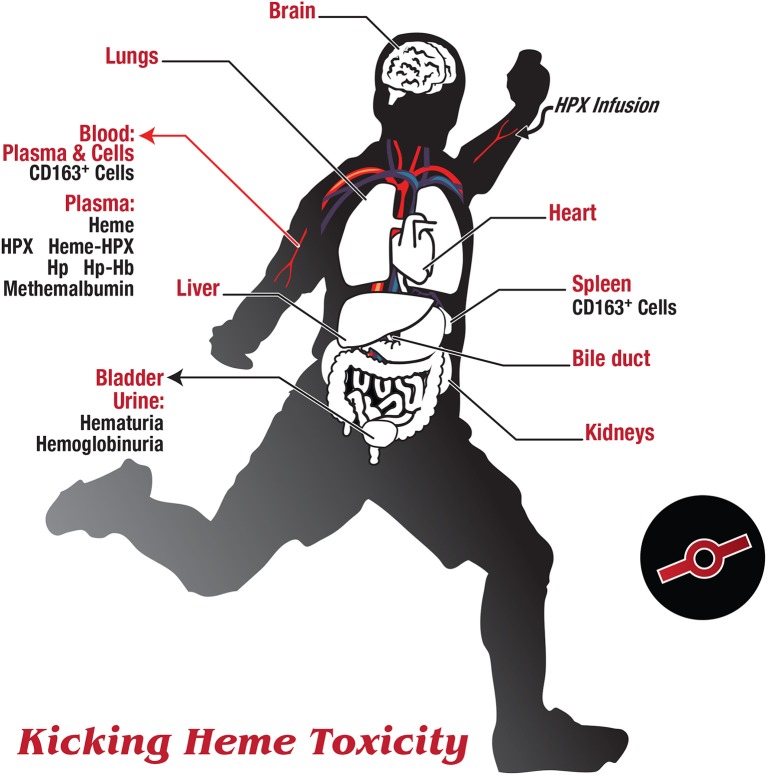
Kicking heme toxicity. As originally suggested by Delanghe et al. (2010) and Drieghe et al. (2013), there is at the bedside a currently unrecognized and potentially quite frequent need to distinguish impaired heme clearance from ongoing hemolysis. Several major organs may be involved in the pathology of heme toxicity, including the liver, lungs, heart, spleen, intestine, and kidney. Certain immune-privileged sites such as the brain and gonads are initially protected by strong endothelial barriers with tight junctions, and certain immune-privileged cells exist in an immunosuppressive environment. Thus, endothelial cells provide a physical barrier and epithelial cells provide a selective cell gate. Several markers in blood and urine samples are indicated here, in addition to the standard liver and kidney function tests and parameters used for the hemolytic index. If routinely measured, e.g., free heme, free HPX and free Hp in plasma, and heme in urine should prove useful in diagnosis and help discern when there is impaired heme clearance due to a HPX deficiency state. As endothelial cells die and lyse they may be the principal source of plasma HO1 (Ghosh et al., 2011) and also raise LDH levels Drieghe et al., 2013. The soluble ectodomain (sed) of scavenger receptors are released into the circulation by proteolysis and it is expected that sedCD163 will bind Hb and/or Hp-Hb, and sedLRP1/CD91 may bind heme-HPX.